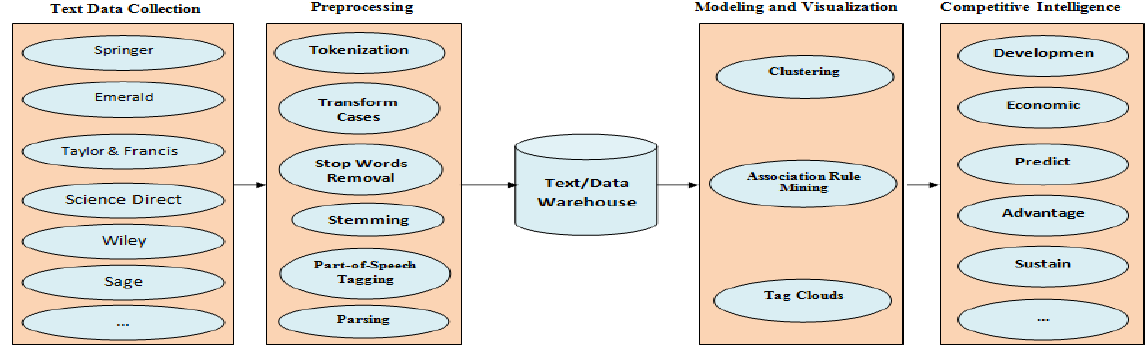
Figure 1. Steps covered in present research